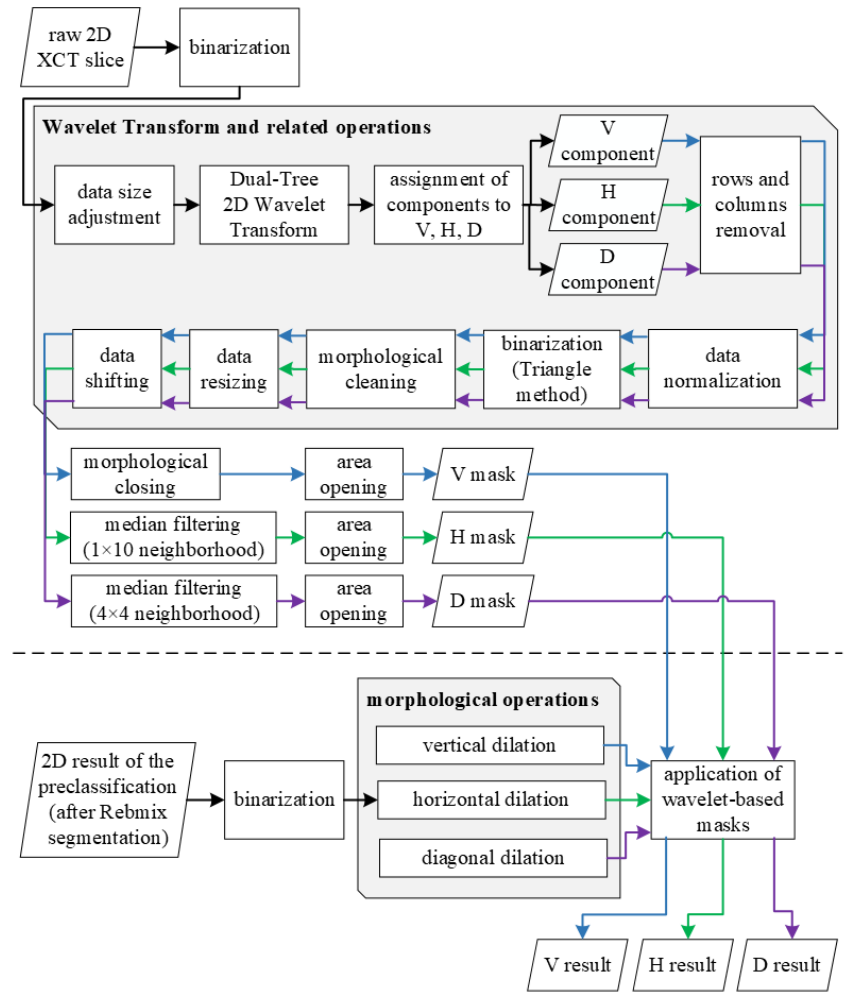
Figure 8. The algorithm of cracks